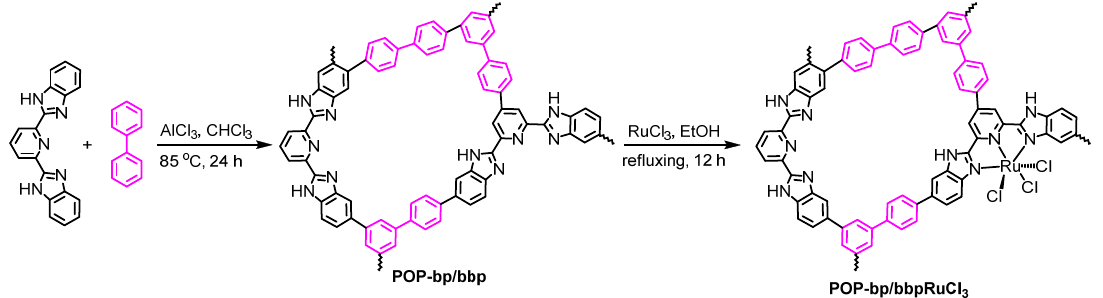
Scheme 1. Synthesis of porous organic polymer (POP)-bp/bbp and POP-bp/bbpRuCl 3 .